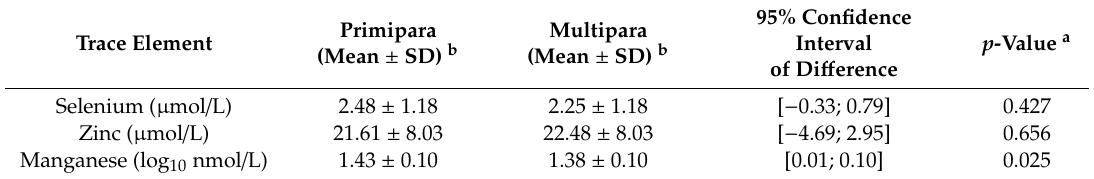
Table 3. Concentrations of selenium, zinc, and manganese in blood serum of pregnant women (primipara vs. multipara).